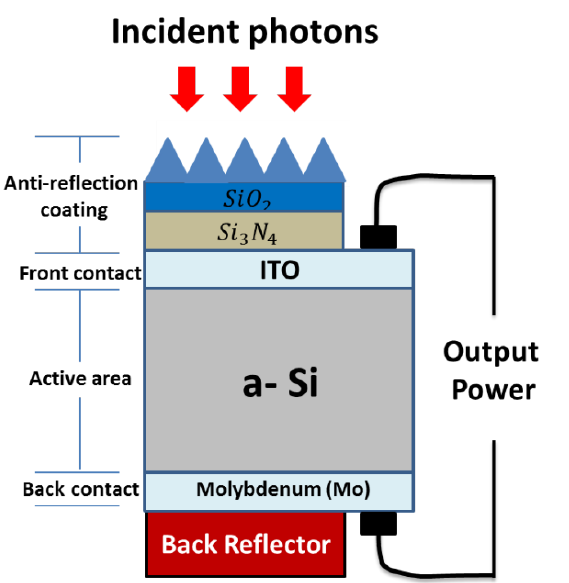
Figure 11. Schematic structure of an amorphous silicon solar cell with two electrodes.